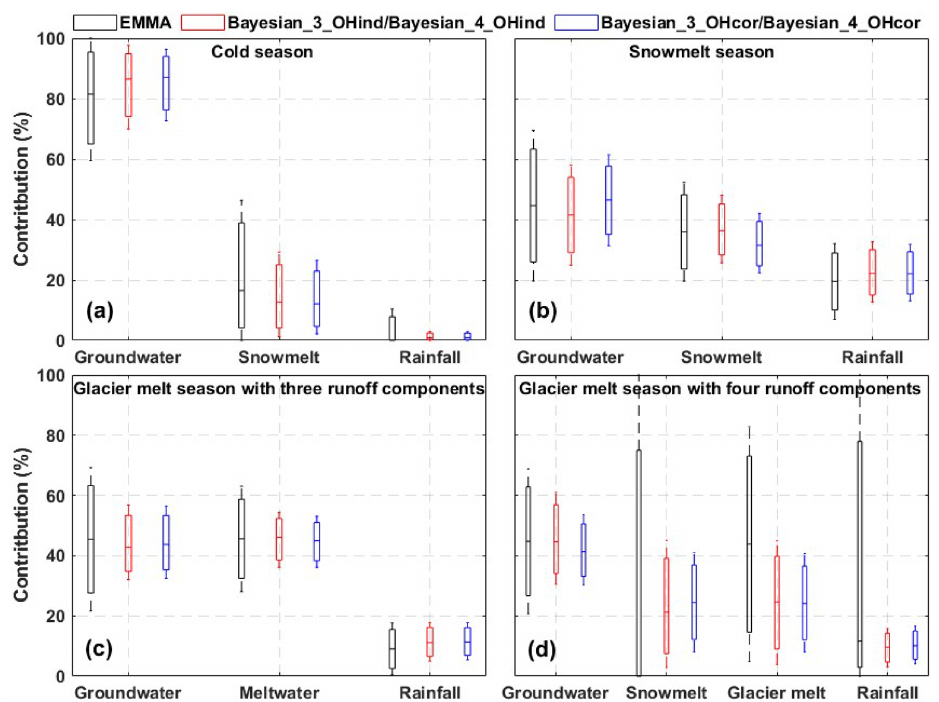
Figure 4. Contributions of runoff components (CRCs) to total runoff estimated by different mixing approaches in three seasons. The Bayesian_3_OHind and Bayesian_3_OHcor were applied in the cold and melt seasons (a–c) , and the Bayesian_4_OHind and Bayesian_4_OHcor were applied in the glacier melt season (d) . The horizontal lines in the boxes refer to the median contributions, and the whiskers refer to the 95% and 5%